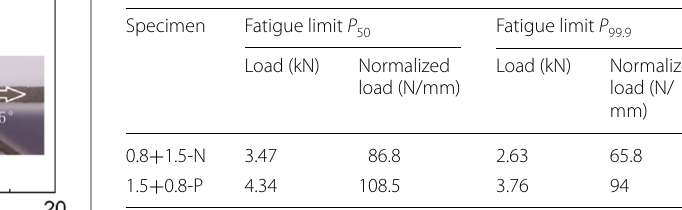
crack in each fractograph propagated from the bottom to Table 3 Fatigue limits with 50% and 99.9% survival rates, presented in load and normalized load by weld length